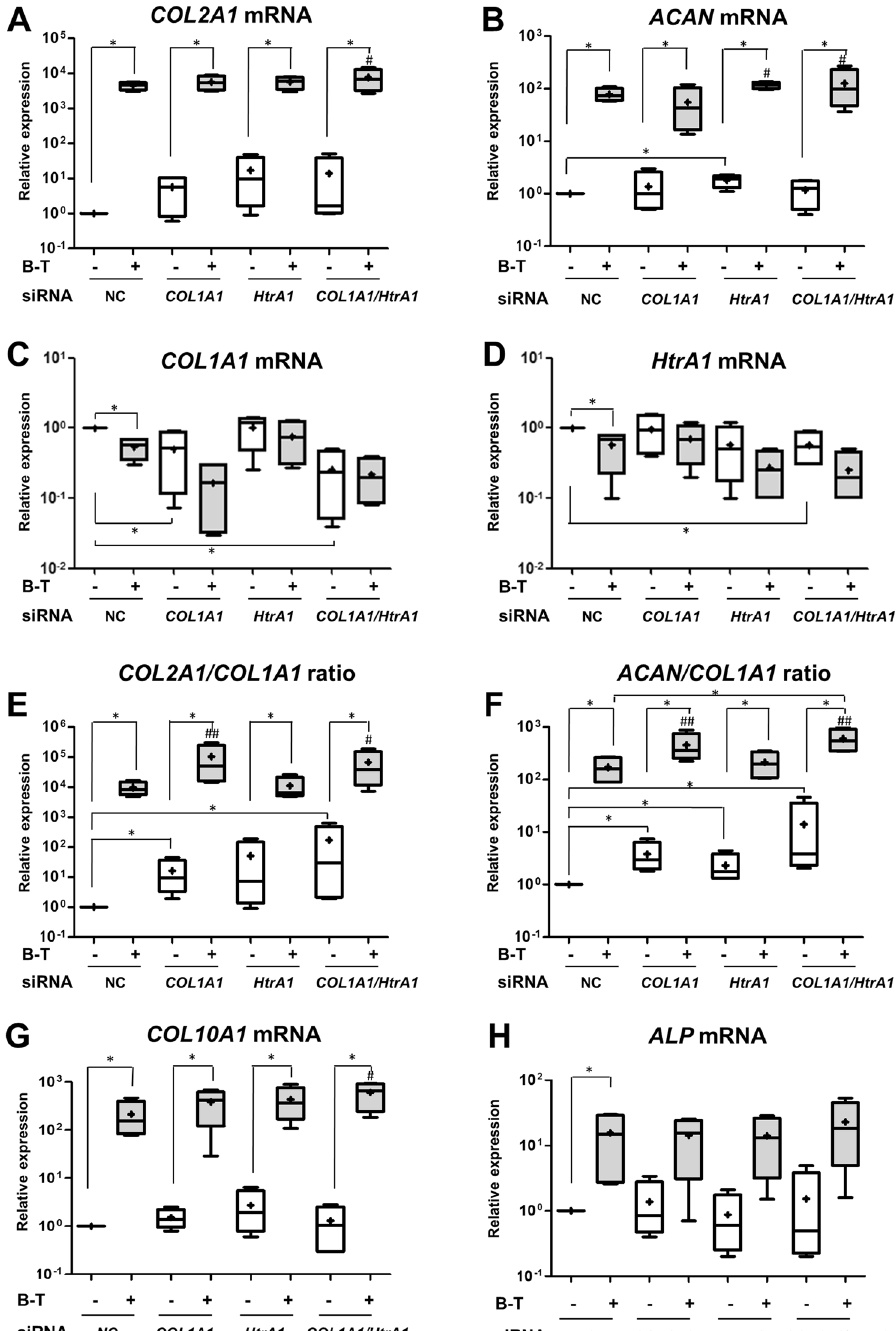
Figure 6. Effects of COL1A1 and/or HtrA1 siRNAs on the mRNA levels of specific and nonspecific cartilage markers. hBM-MSCs seeded onto collagen sponges were transfected with an INTERFERin ® -siRNA complex (100 nM negative control (NC) siRNA, or 100 nM COL1A1 siRNA and/or 100 nM HtrA1 siRNA) at days 0 and 7 as described in Materials and Methods. hBM-MSCs were cultured in 3% O 2 for 14 days with or without ( − ) both 50 ng/mL BMP-2 and 10 ng/mL TGF- β 1 (B-T). Relative mRNA expressions of type II collagen ( A ), aggrecan ( B ), type I collagen ( C ), HtrA1 ( D ), type X collagen ( G ), and alkaline phosphatase ( H ) were obtained as described in Figs 3–4. All results were normalized to RPL13a mRNA, and are presented as the expression of each gene relative to that of untreated NC cells. We also determined the COL2A1 / COL1A1 mRNA ratio ( E ) and the ACAN / COL1A1 mRNA ratio ( F ). Box plots represent the results from independent experiments performed in triplicate (n = 4). Statistically significant differences between the untreated NC cells and the different treatments were determined using the Kruskall-Wallis test ( # P < 0.05). Statistically significant differences between untreated cells and BMP-2/TGF- β 1-treated cells, NC siRNA-untreated cells, and other siRNA- untreated cells, and between NC siRNA BMP-2/TGF- β 1-treated cells and other siRNA BMP-2/TGF- β 1-treated cells were determined using the Mann-Whitney U test ( * p <